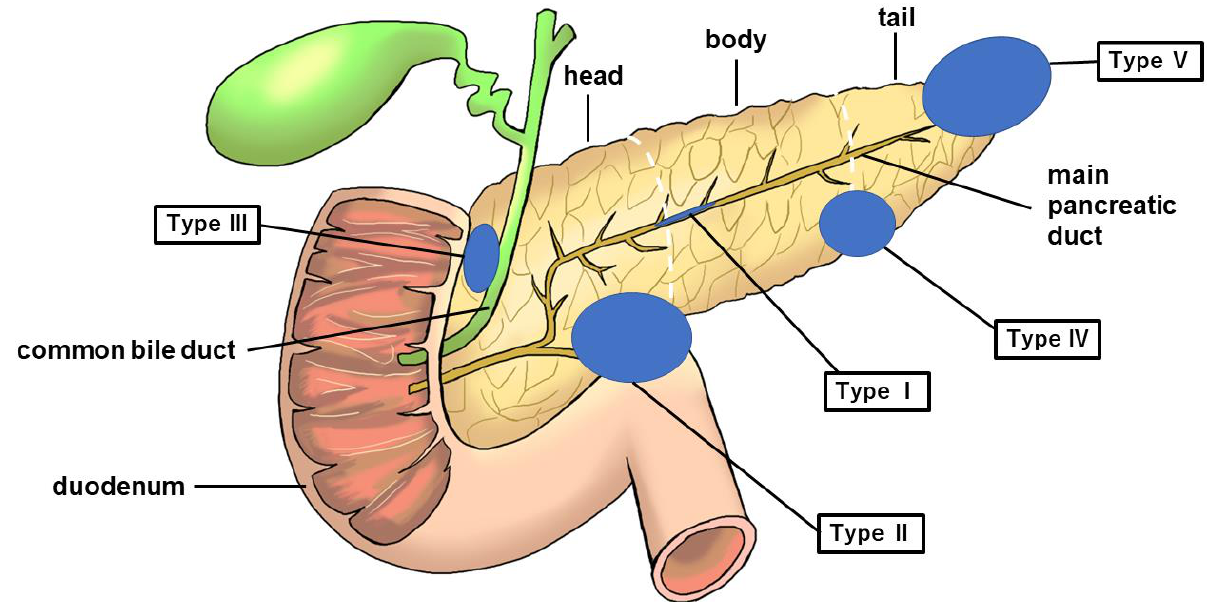
Figure 3. Figure showing five categories of PDAC without MPD dilatation. The blue circle represents the tumor. PDAC, pancreatic ductal adenocarcinoma; MPD, main pancreatic duct. Type I: No mass can be detected using any imaging modality. The MPD is narrowed, localized pancreatic atrophy is observed, or EUS shows a hypoechoic area surrounding the MPD stenosis. All locations are considered acceptable. A typical example is a carcinoma-in situ (Figure 4).